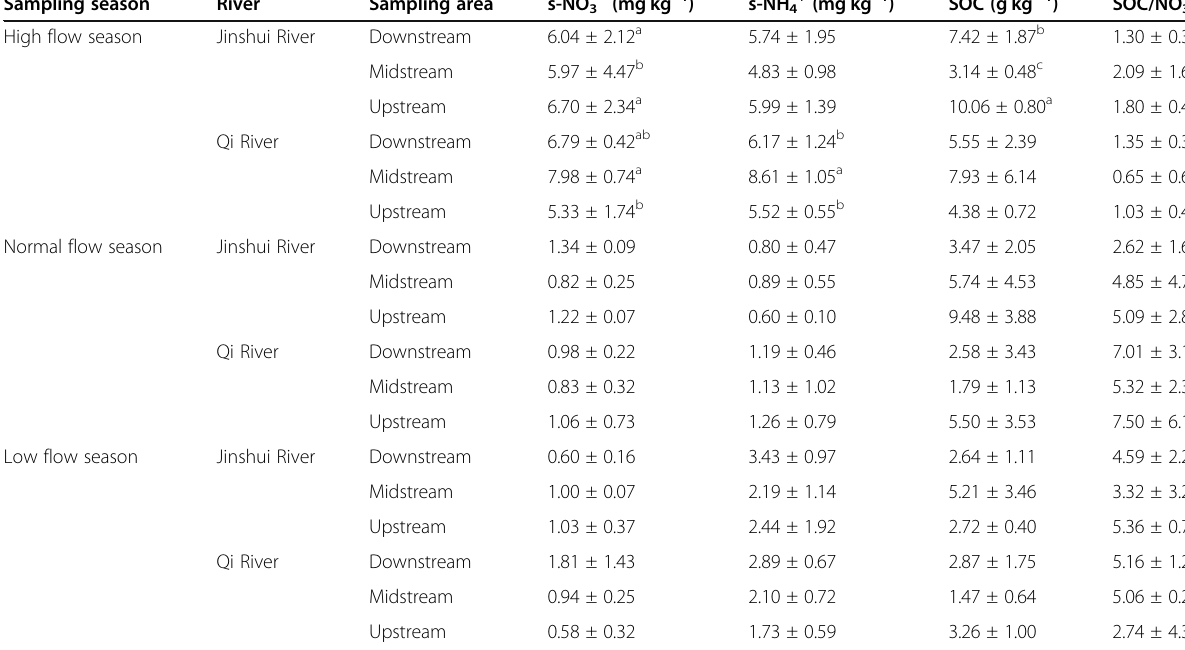
Table 2 Sediment physicochemical variables of Jinshui River and Qi River Sampling